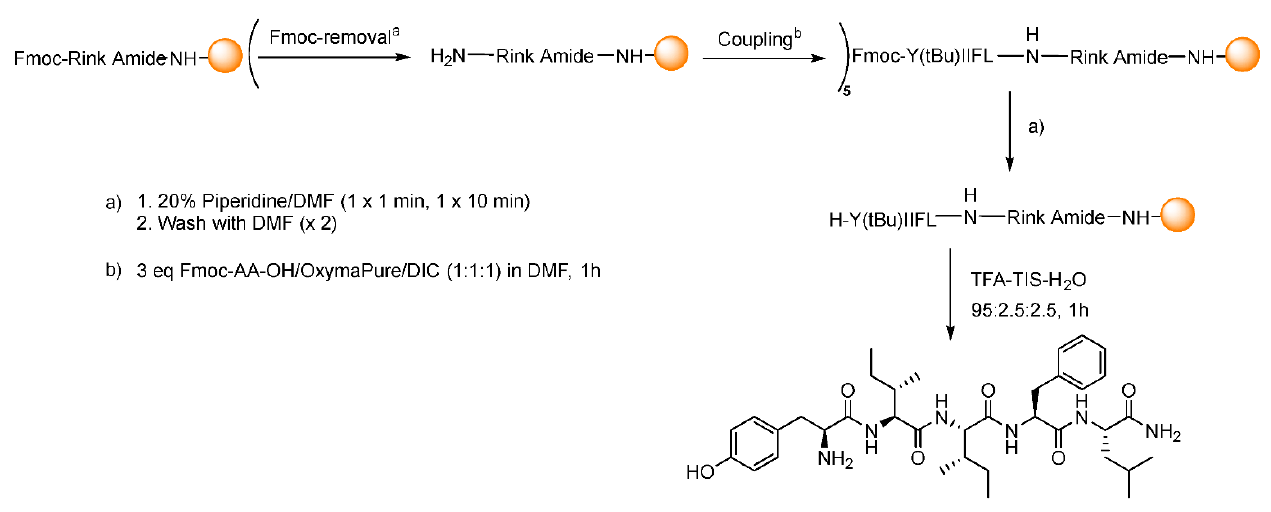
Scheme 2. Schematic illustration of the synthesis of H-YIIFL-NH